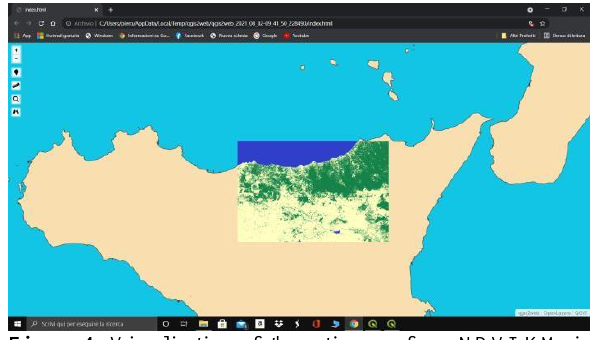
Figure 4. Visualization of thematic map from NDVI KM in web format in overlap with the Italian Region vector